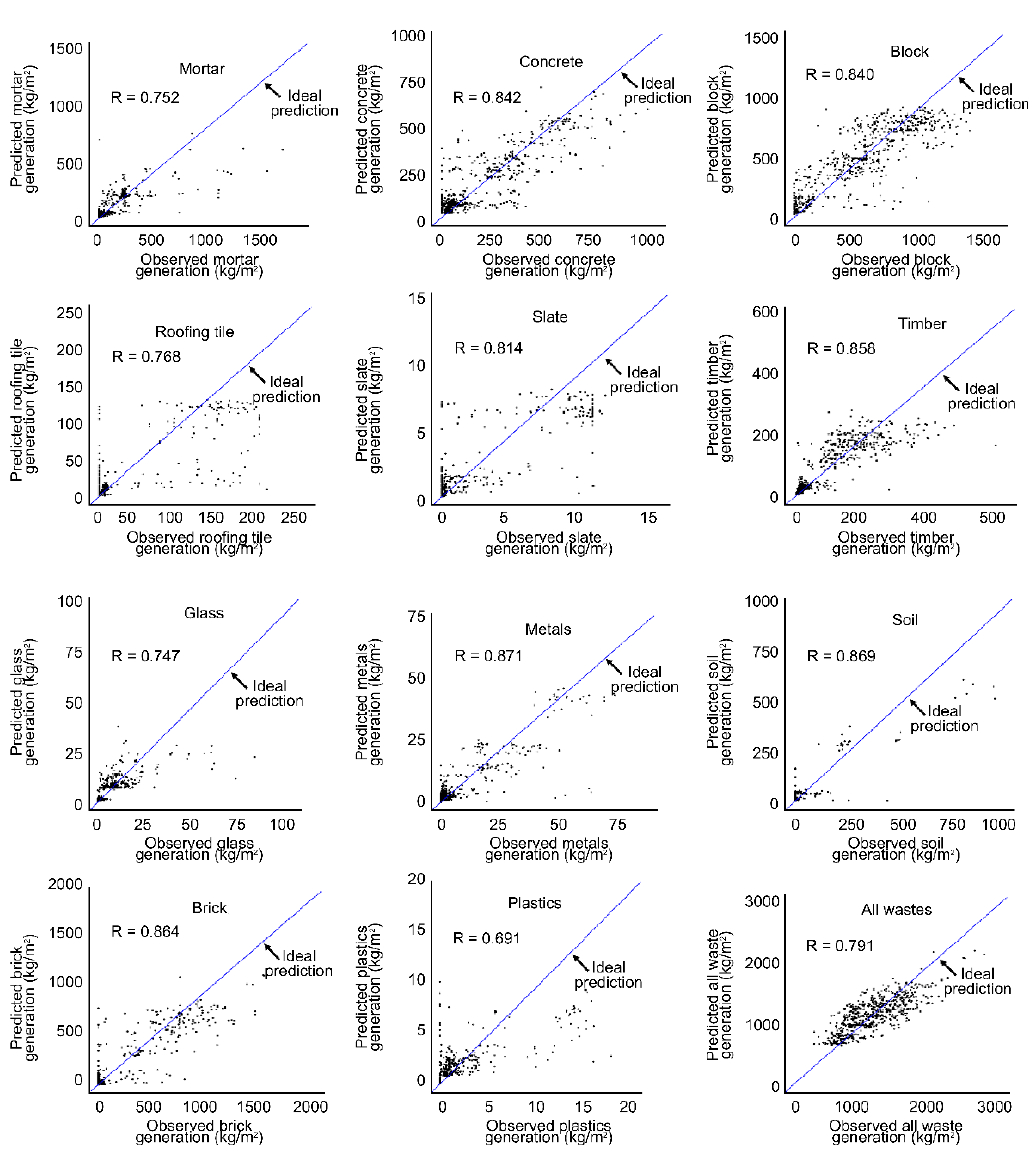
of observations 188.6 kg / m 2 , mean of predicted value 188.1 kg / m 2 ), timber (R = 0.858; R 2 = 0.735; input variables: Region, roofing material, GFA, structure, and building use; mean of observations 96.02 kg / m 2 , mean of predicted value 96.06 kg / m 2 ), metal (R = 0.871; R 2 = 0.755; input variable: Region, building use, roofing material, wall material, and structure; mean of observations 7.36 kg / m 2 , mean of predicted value 7.40 kg / m 2 ), and soil (R = 0.869; R 2 = 0.800; input variables: Region, building use, roofing material, wall material, and structure; mean of observations 20.77 kg / m 2 , mean of predicted value 20.82 kg / m 2 ). From the RF model for a building that includes all DWs, the correlation between values predicted by the RF model and values observed from the actual survey was R = 0.791 and R 2 = 0.615. The mean observed and predicted values for all wastes were 1165.04 kg / m 2 and 1166.258 kg / m 2 , respectively,